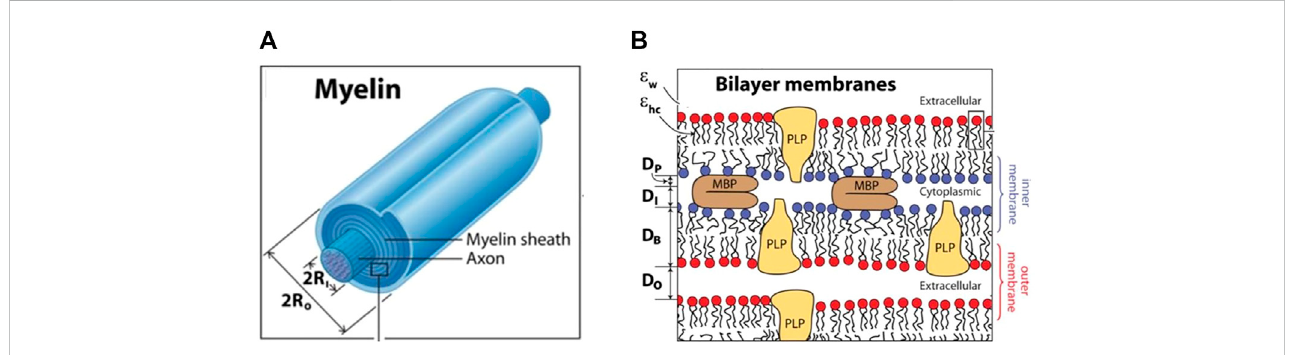
FIGURE 1 The structure of the myelin sheath. The myelinated axon (A) , bilayer membranes (B) . (A) : The ratio of 2xRo to 2xRi (in A) is the g-ratio. Ri — inner radius; Ro — outer radius (B) : Each bilayer of thickness DB is separated by cytoplasmic and extracellular water gaps of thicknesses DI and DO, and effective protein thickness DP is occupied by the fraction of MBP constituting the cytoplasmic water gap. Adapted from Min Y, et al. Proc Natl Acad Sci U S A. 106(9): 3154 –